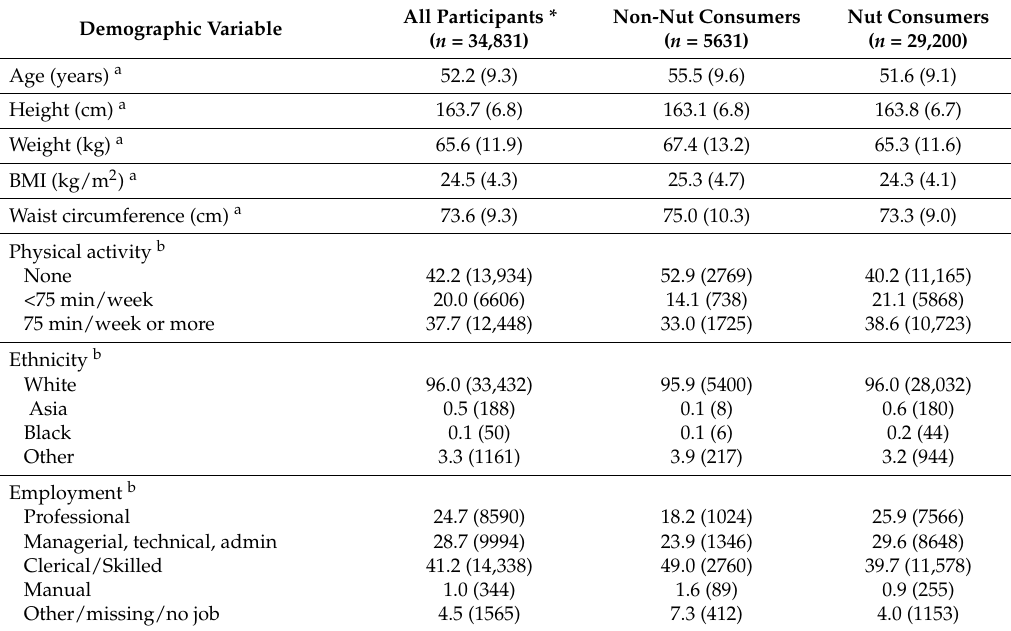
Table 1. Characteristics of study participants by nut